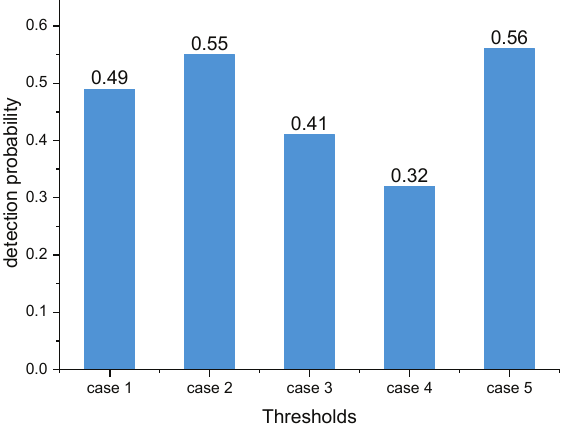
Figure 6. Detection probability of FTC in different fixed